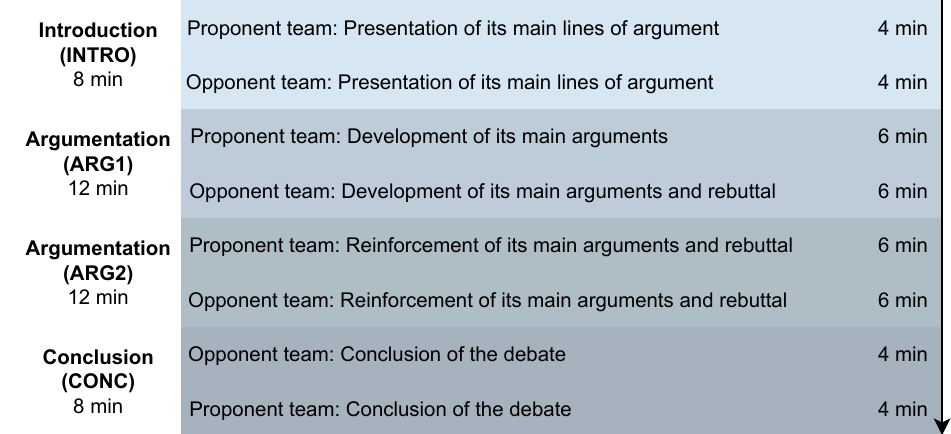
Figure 2. General structure for academic debate